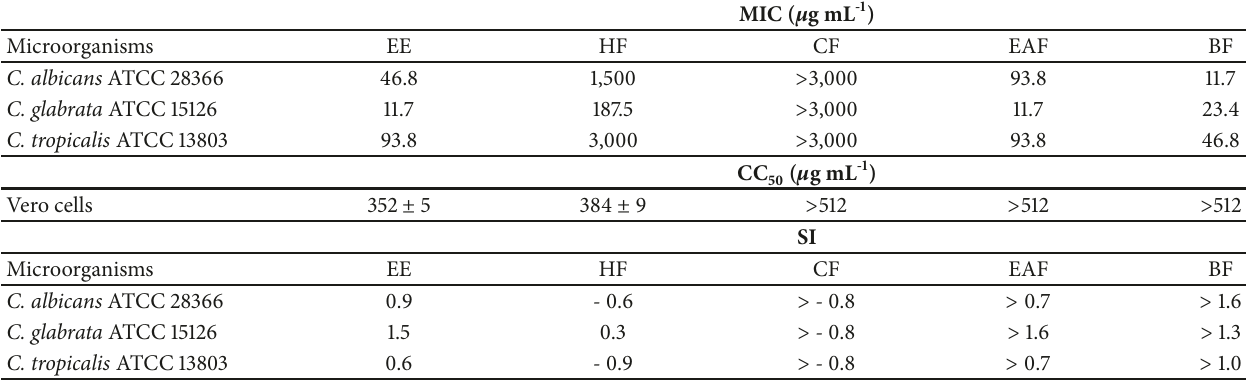
Table 2: Results of antifungal activity (expressed as MIC in 𝜇 g mL −1 ), cytotoxic activity (expressed as CC 50 in 𝜇 g mL −1 ), and selectivity index for extract and fractions of I. laurina